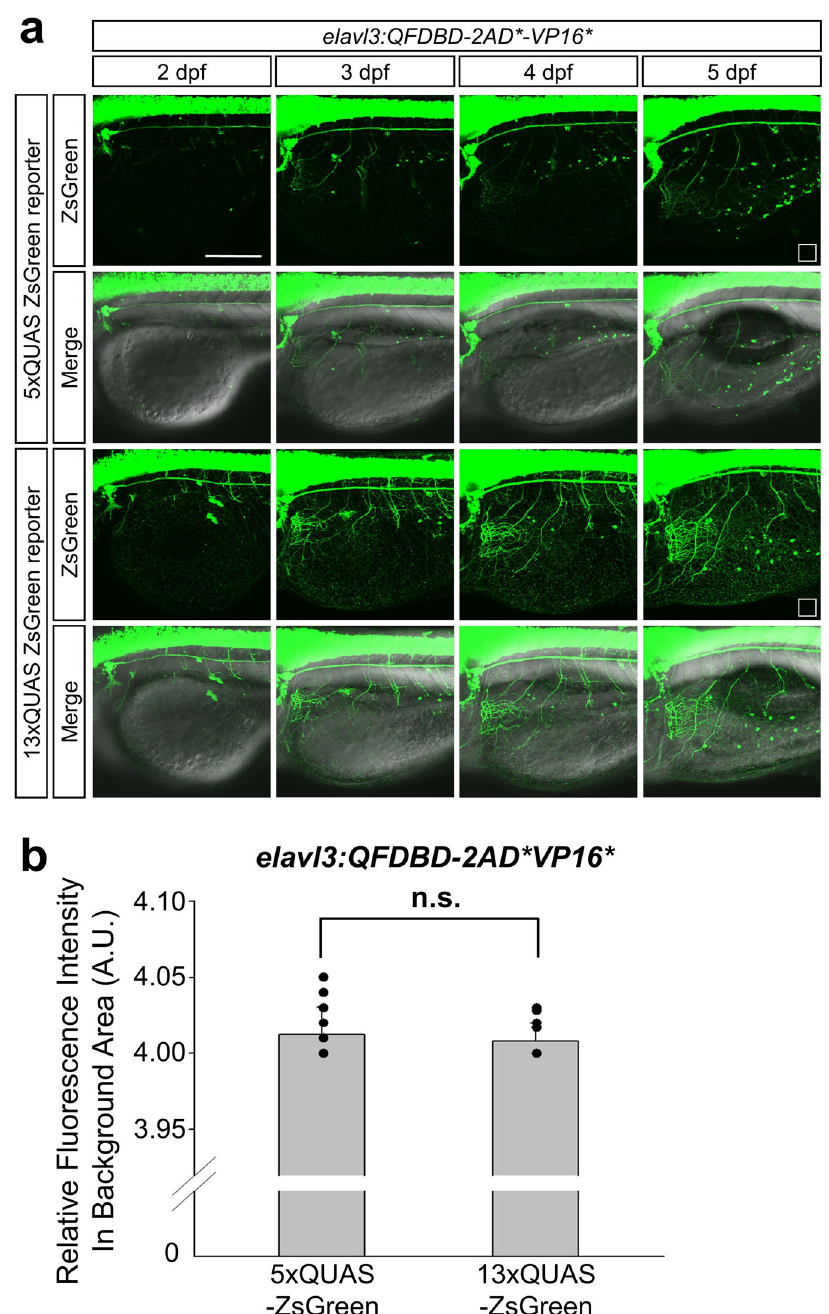
Fig. 6 The intensity of ZsGreen was gradually mounting on the sensory neurons in EYL across embryonic growth. a Representative image of embryos at the indicated developmental stage. They obtained from genetic crosses between F2 Tg(elavl3:QFDBD-2xAD*-VP16*) and F3 effector lines having 5x or 13xQUAS-regulated ZsGreen reporter gene. b The points labeled with white open square box in ( a ) stand for the region used to level off background fl uorescence intensity of 5x and 13xQUAS-ZsGreen groups. Comprehensive level of background fl uorescence was measured with 12 single images derived from same number of embryos at 5 dpf under the identical confocal setting. No discernable differences were observed in two discrete clutches. Twelve embryos in each clutch were analyzed in the assay. Abbreviations: A.U.; arbitrary unit, n.s.; not signi fi cant, Teb; tebufenozide. Scale bar: 200 μ